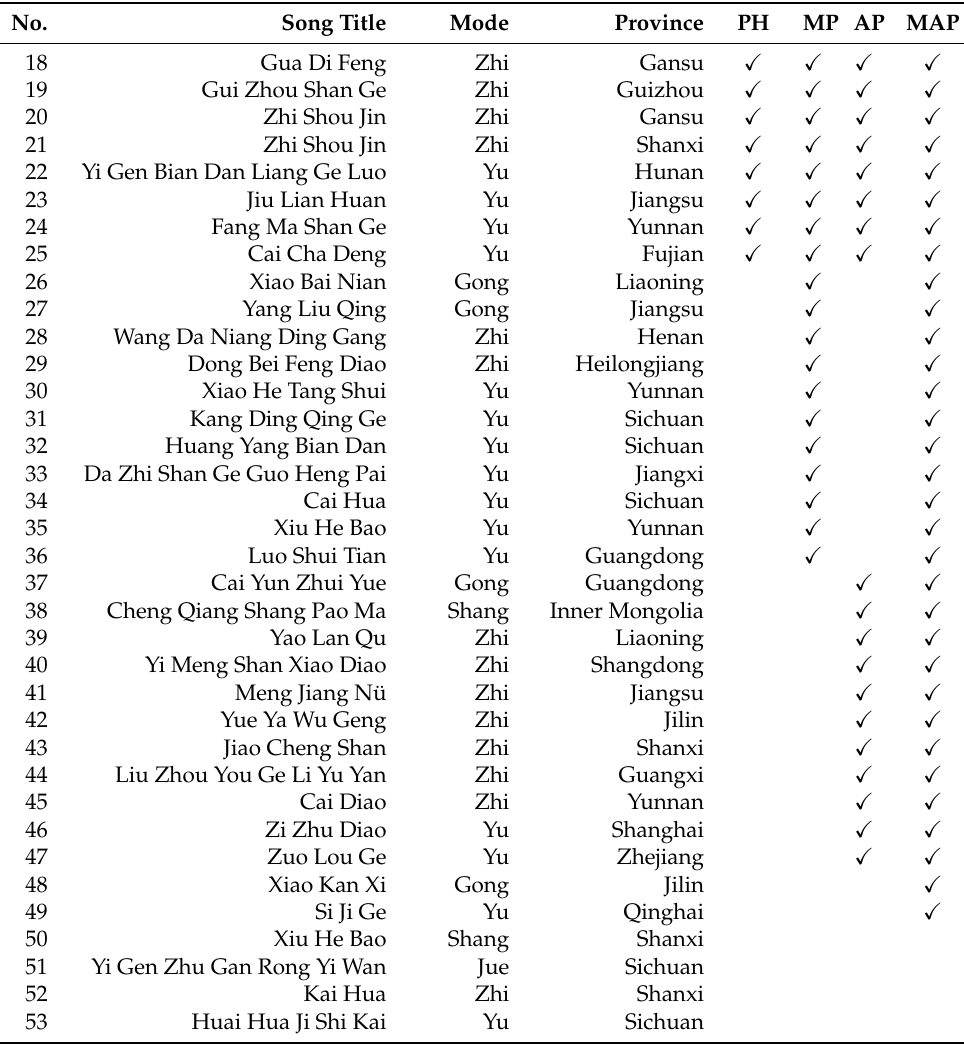
Table A1. Cont. No.